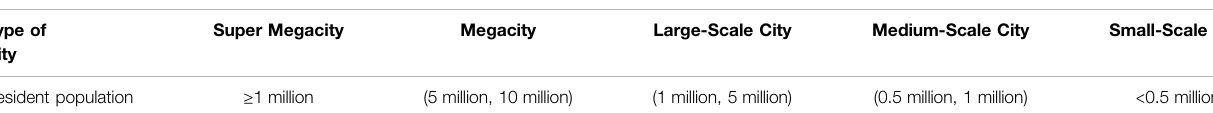
TABLE 3 | City-size classi fi cation standard in China.